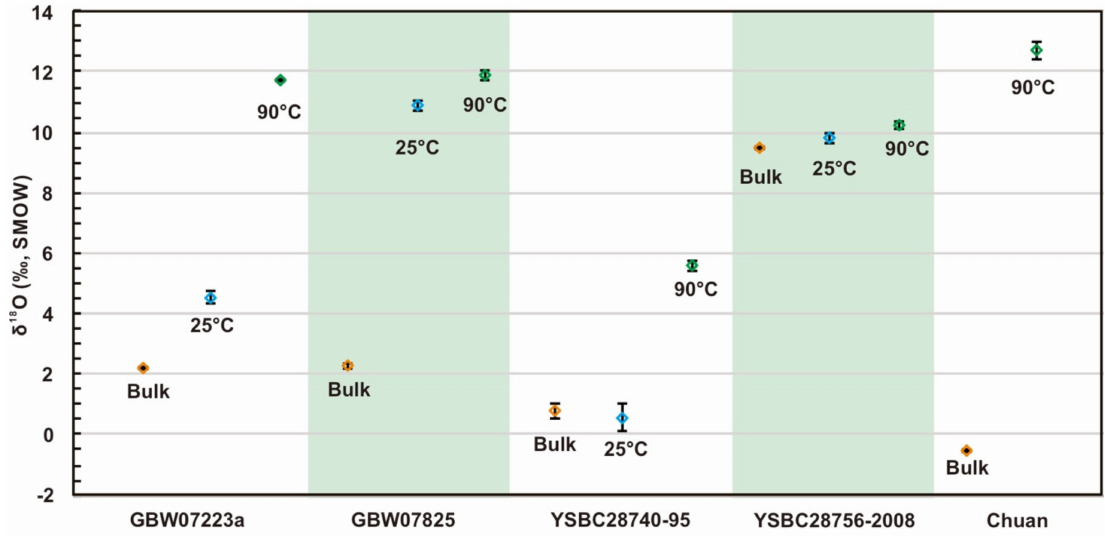
Figure 3. Oxygen isotope ratios of iron oxide reference materials (RMs) and residues after the HCl dissolution treatment at room temperature (25 ◦ C) and 90 ◦ C. The orange rhombi represent the bulk rock δ 18 O. The blue rhombi represent the reaction at room temperature. The green rhombi represent the 90 ◦ C condition. The error bars represent 1 σ